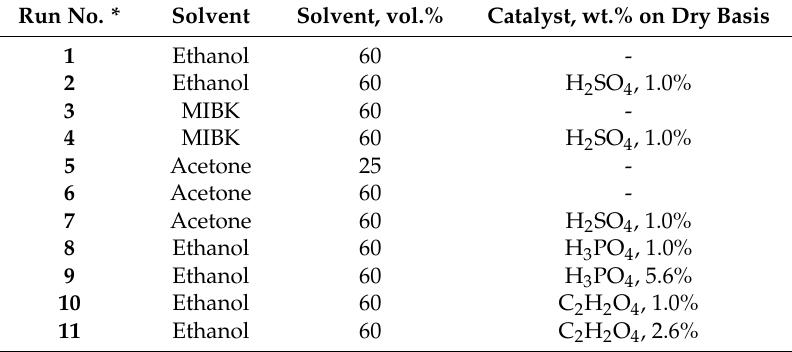
Table 1. Experimental conditions for the organosolv pretreatment. Run No. * Solvent Solvent, vol.%